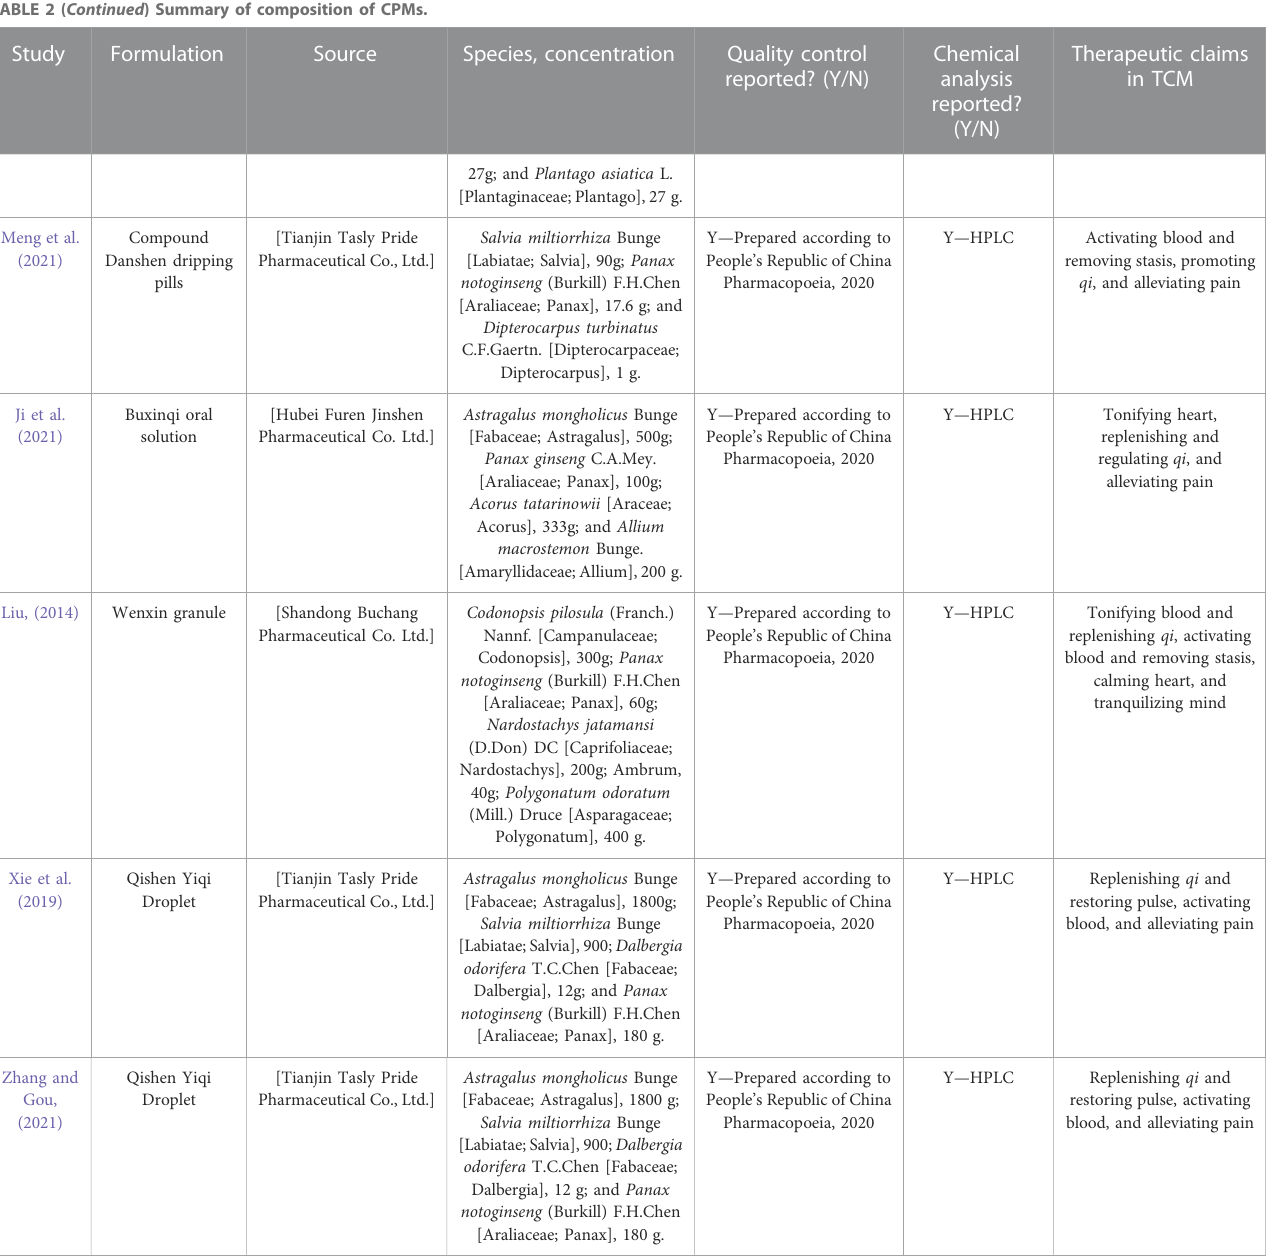
The pairwise comparison outcome of LVEDD is presented in Table 6 and Supplementary Figure S2C. Compared to WM, KWYR- CPM + THSWT + WM was superior to other treatment regimens in reducing LVEDD. Meanwhile, compared with WM, QR&BASR-CPM